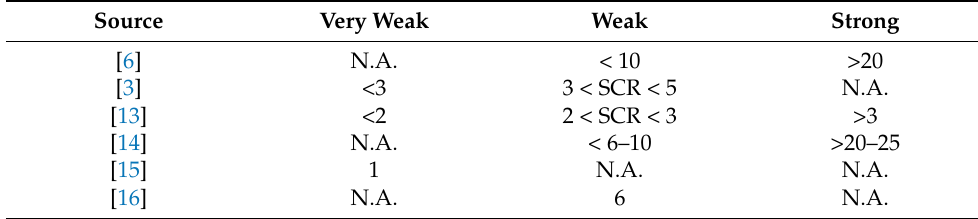
Table 2. Grid strength for defining SCR levels.